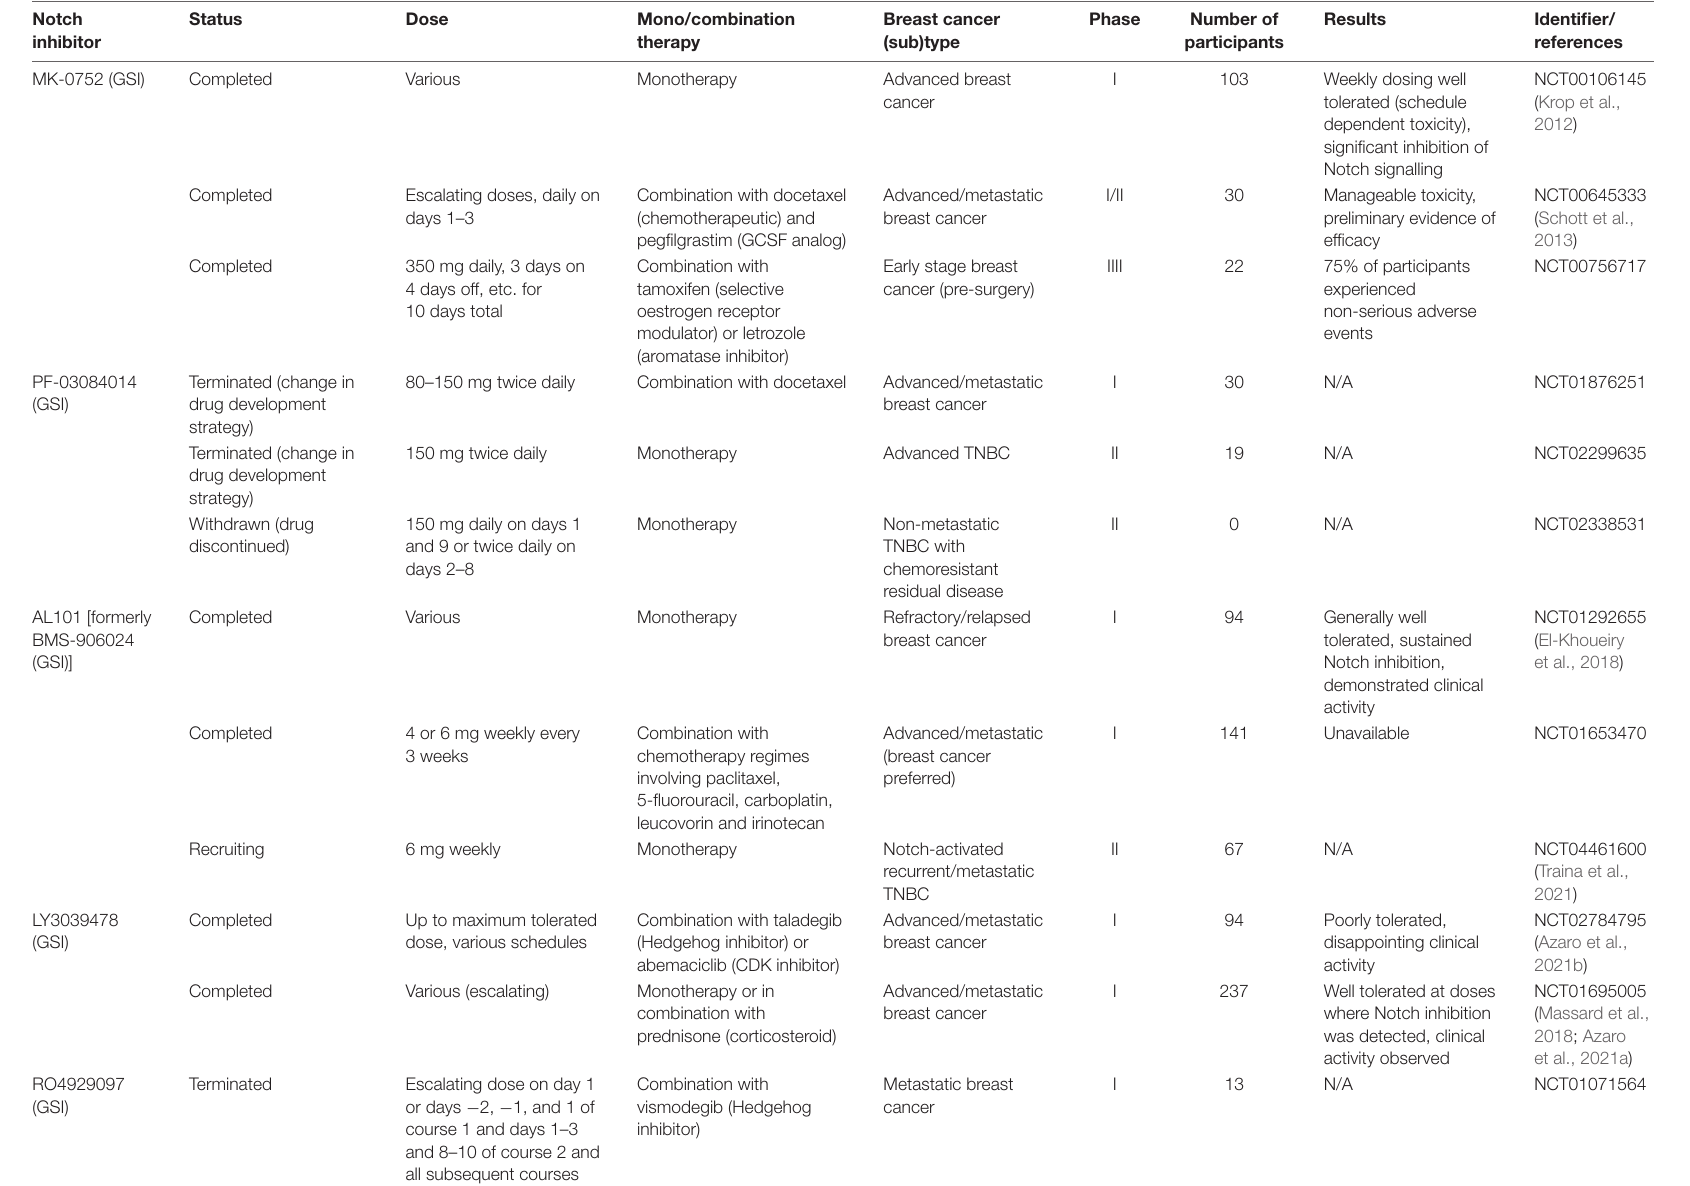
TABLE 1 | Notch inhibitor clinical trials featuring breast cancer patients. Notch